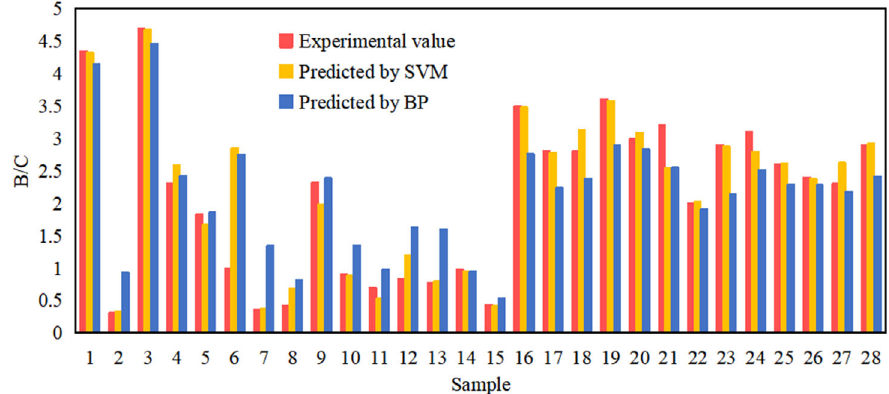
Fig. 7 Predicted B/C without reactor scale (input variables are T , Q , P , ID , In_BCl 3 , In_CH 4 , and In_H 2